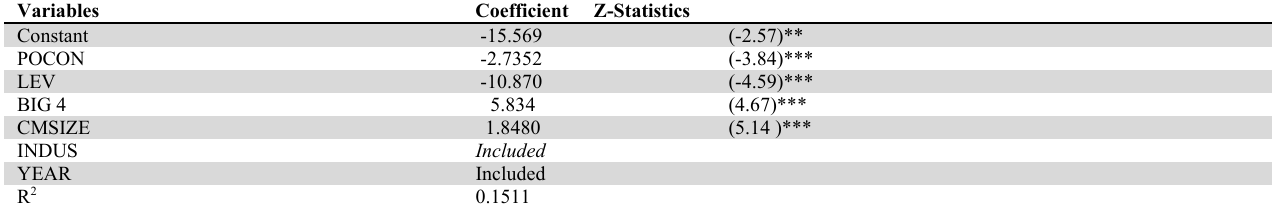
Main regression results (PCSE) for Model (Dependent Variables= ROE and 2200 Observations) Variables